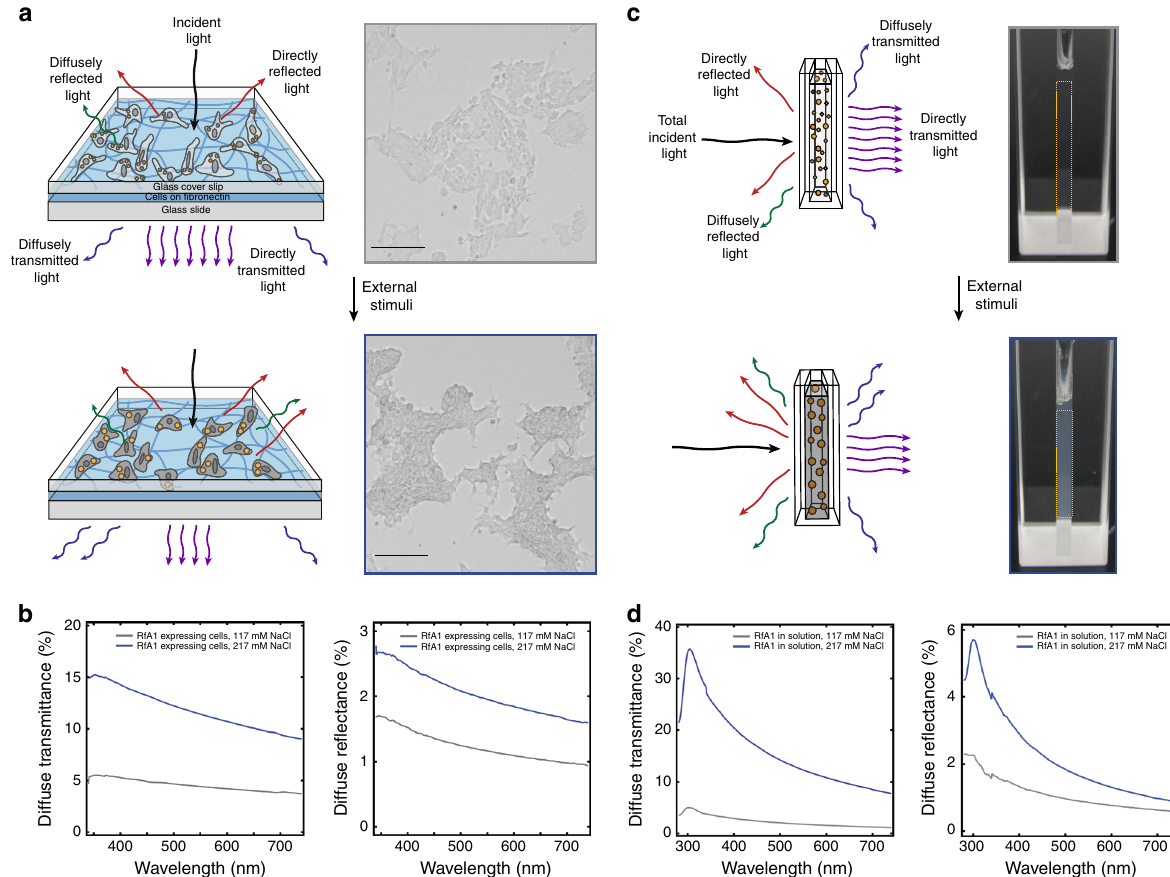
Fig. 4 Demonstration of tunable optical properties for engineered human cell cultures. a (Top) A schematic (left) and representative bright fi eld microscopy image (right) of a sandwich-type con fi guration, wherein the middle layer consists of an RfA1-expressing cell culture, after exposure to media with a standard, i.e. 117 mM, NaCl concentration. The cells do not substantially attenuate incident light and appear similar to their environment. (Bottom) A schematic (left) and representative bright fi eld microscopy image (right) of a sandwich-type con fi guration, wherein the middle layer consists of an RfA1- expressing cell culture, after exposure to media with a higher, i.e. 217 mM, NaCl concentration. The cells more strongly attenuate light and appear relatively distinct from their environment. The scale bars are 225 µ m in both images. b (Left) Representative diffuse transmittance spectra obtained for sandwich- type con fi gurations from RfA1-expressing cells after exposure to media with standard (gray trace) and higher (blue trace) NaCl concentrations. (Right) Representative diffuse re fl ectance spectra obtained for sandwich-type con fi gurations from RfA1-expressing cells after exposure to media with standard (gray trace) and higher (blue trace) NaCl concentrations. c (Top) A schematic (left) and representative digital camera image (right) of a cuvette containing an aqueous RfA1 solution with a 117 mM NaCl concentration. The solution, which contains small RfA1 nanoparticles (orange spheres), appears visibly transparent and weakly scatters incident light. (Bottom) A schematic (left) and representative digital camera image (right) of a cuvette containing an aqueous RfA1 solution with a 217 mM NaCl concentration. The solution, which contains much larger RfA1 nanoparticles (orange spheres), appears visibly opaque and more strongly scatters incident light. d (Left) Representative diffuse transmittance spectra obtained for aqueous RfA1 solutions with 117 mM (gray trace) and 217 mM (blue trace) NaCl concentrations. (Right) Representative diffuse re fl ectance spectra obtained for aqueous RfA1 solutions with 117 mM (gray trace) and 217 mM (blue trace) NaCl